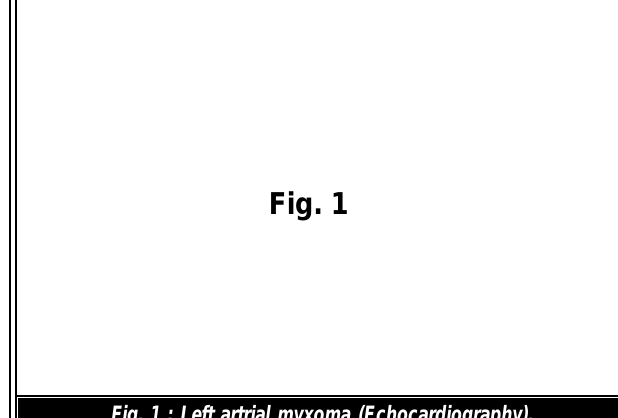
Fig. 1 : Left artrial myxoma (Echocardiography). Fig. 2 : Villous and friable myxoma occupying almost entire left atrium (the largest tumor).